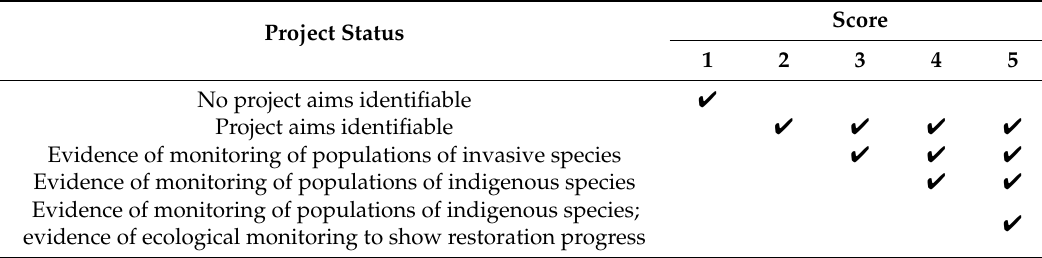
Table 2. Scoring criteria for characterisation of the monitoring status of ecological restoration projects.